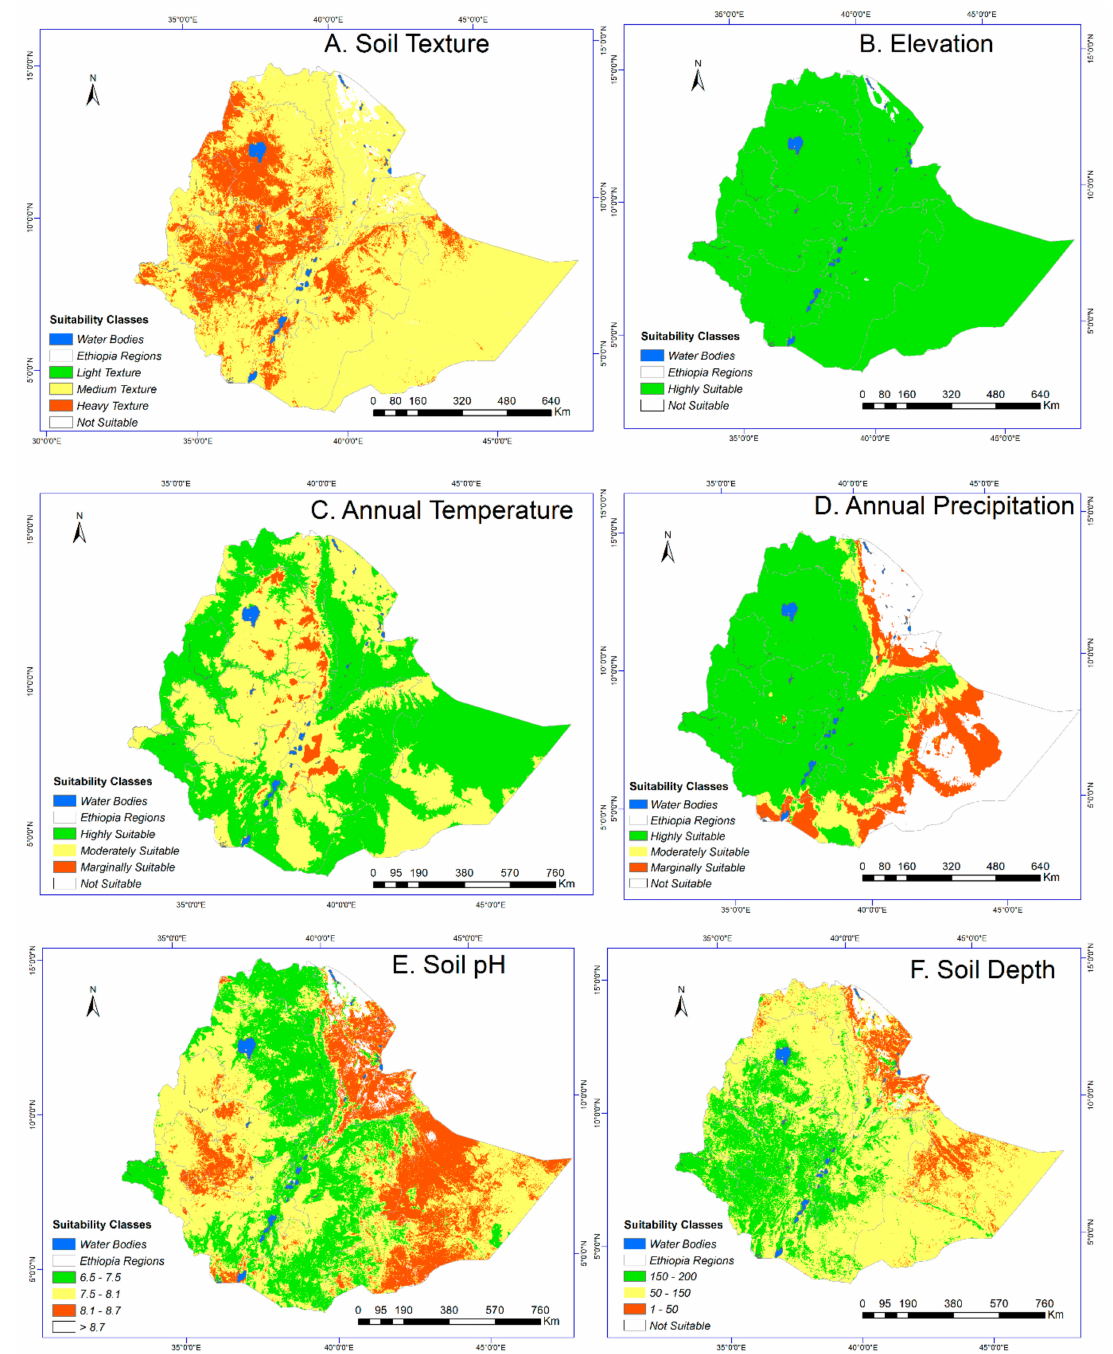
Figure 4. Land suitability maps for Alfalfa (Medicago sativa) based on soil texture ( A ), elevation ( B ), annual temperature ( C ), annual precipitation ( D ), soil pH ( E ) and soil depth ( F ). The factors were classified based on optimal and absolute growth parameters in Ecocrop (see Table